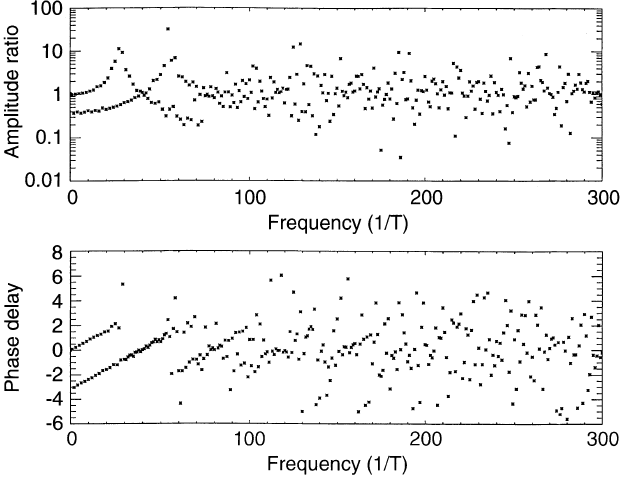
Fig. 6. The amplitude ratio and the phase di(cid:128)erence of the time stationary, Hanning windowed datasets. The abscissas denote the frequency in units of D f , the ordinate of the upper plot the amplitude ratio and of the lower plot the phase di(cid:128)erence. The zero frequency as well as frequencies higher than 300 D f